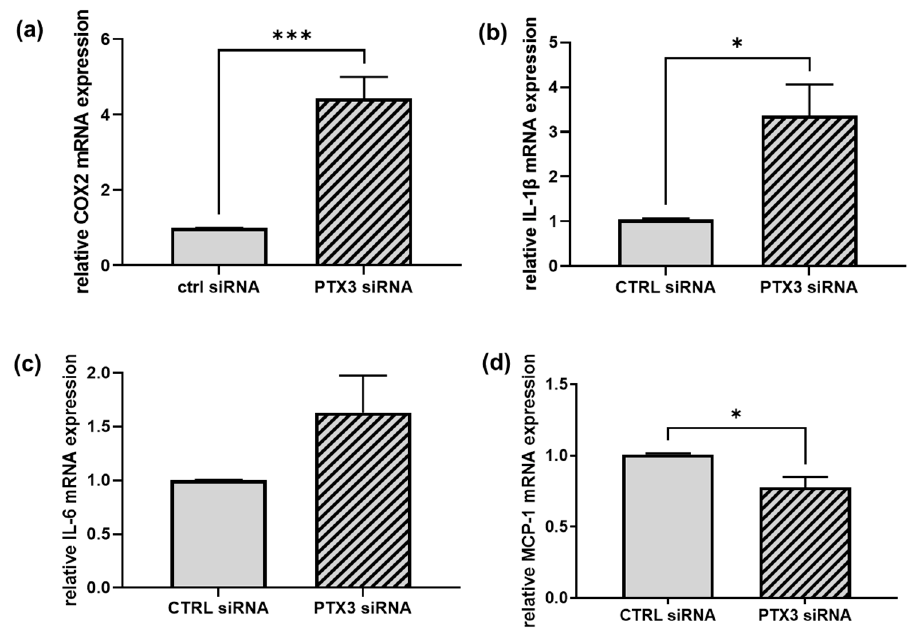
Figure 4. The effect of silencing PTX3 on the inflammatory profile of ECs. RT-qPCRs were performed on mRNAs prepared from ECs transfected for 48 h with control siRNA (CTRL siRNA, solid bars) or PTX3 siRNA (diagonal bars). In ( a ), COX-2 mRNA was normalized to the housekeeping gene 18S; in ( b ), ( c ), and ( d ), IL-1 β , IL-6 and MCP-1 mRNAs were normalized to GAPDH. ( a ), *** p < 0.001, n = 4. ( b ) * p < 0.05, n = 3. ( c ) p = 0.143, n = 3. ( d ) * p < 0.05, n = 4.